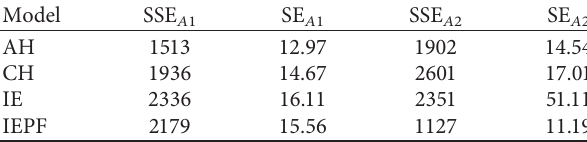
Table 3: Accuracy of each model for example 1.